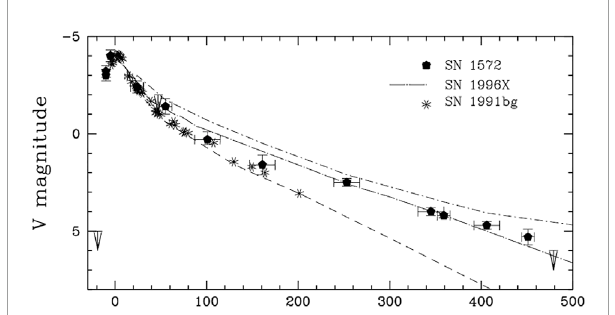
FIGURE 3 The visual light curve of SN 1572 till 500 days. Its late rate of decline is the one of normal SNe Ia. It is very similar to the decline of the s = 0.889 SN 1996X. The visual data of SN 1991bg and the template light curves of this SN Ia and SN 1991T are shown for comparison. Figure in R04. © AAS. Reproduced with